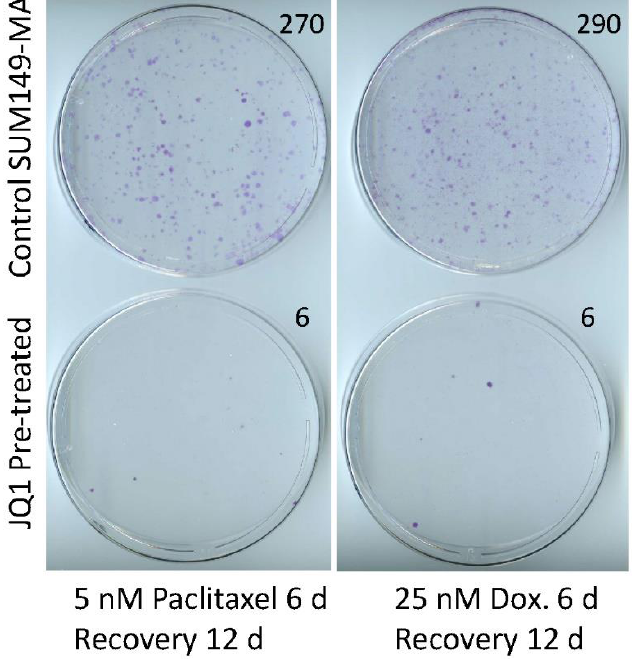
Figure 2. Treatment with JQ1 sensitizes SUM149-MA cells to treatment with chemotherapeutic drugs. After 6 days of treatment with 1 µM of JQ1, we allowed surviving cells to recover in a drug-free medium for 9 days. Following this, we trypsinized the cells, plated them into fresh culture dishes, treated them in parallel with 5 nM of paclitaxel (left panel) or 25 nM of doxorubicin (Dox, right panel) for 6 days, and then let them recover and grow into colonies for 12 days before staining them with crystal violet. Representative images of cell cultures are shown. These images show that pretreatment with JQ1 markedly decreased the number of colonies. Passage number in cell culture: passage 7.